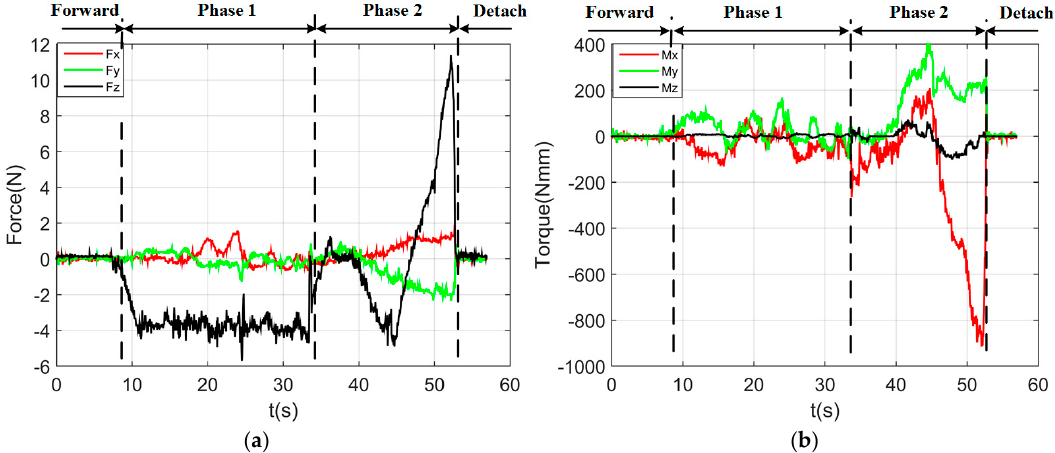
Figure 12. Round pieces: interacting forces and torques toward single-arm operation (Phase 1: outside adjustment phase; Phase 2: inside adjustment phase). ( a ) Interaction forces; ( b ) interaction torques.